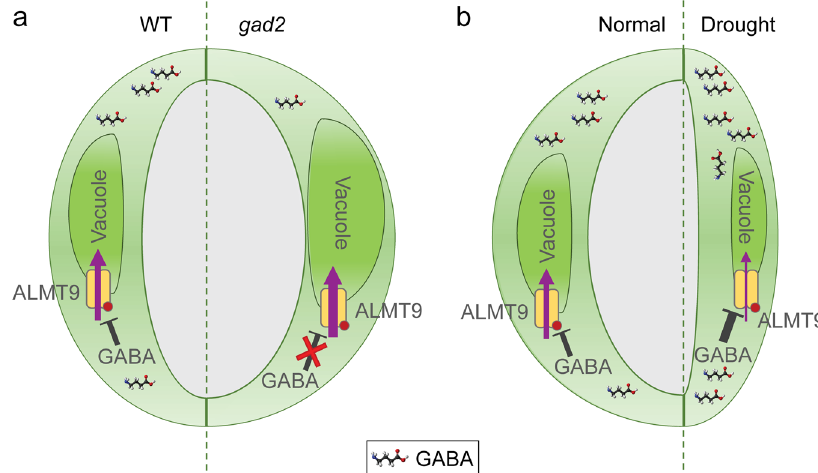
Fig. 10 Proposed model of GABA-mediated signalling for the regulation of water use ef fi ciency. a Cytosolic guard cell GABA negatively regulates ALMT9-mediated anion uptake into guard cell vacuoles, which fi ne tunes stomatal opening (left guard cell of pair). Depletion of GABA accumulation in the leaves of GAD2 loss-of-function mutant ( gad2 ) de-regulates ALMT9, maximizing anion uptake and accumulation in guard cell vacuoles. This leads to a more open stomatal pore, greater water loss and lower WUE of plants (right guard cell of pair). This stomatal phenotype can be replicated by replacing F243/Y245 (red dot) with two cysteines, which abolishes GABA sensitivity of ALMT9. b Leaf GABA synthesized and accumulated during water de fi cit reduces ALMT9-mediated vacuolar anion uptake into guard cells, which requires amino acid residues F243/Y245 (red dot) (right guard cell of pair). This reduces stomatal opening, reducing the pore aperture and enhances plant WUE under drought stress compared to guard cells under standard conditions in the light (left guard cell of pair). Note: We have excluded ALMT12 from this model as we did not fi nd a role for this protein in GABA modulation of water use ef fi ciency in planta, despite its role in GABA modulation of stomatal aperture found within epidermal